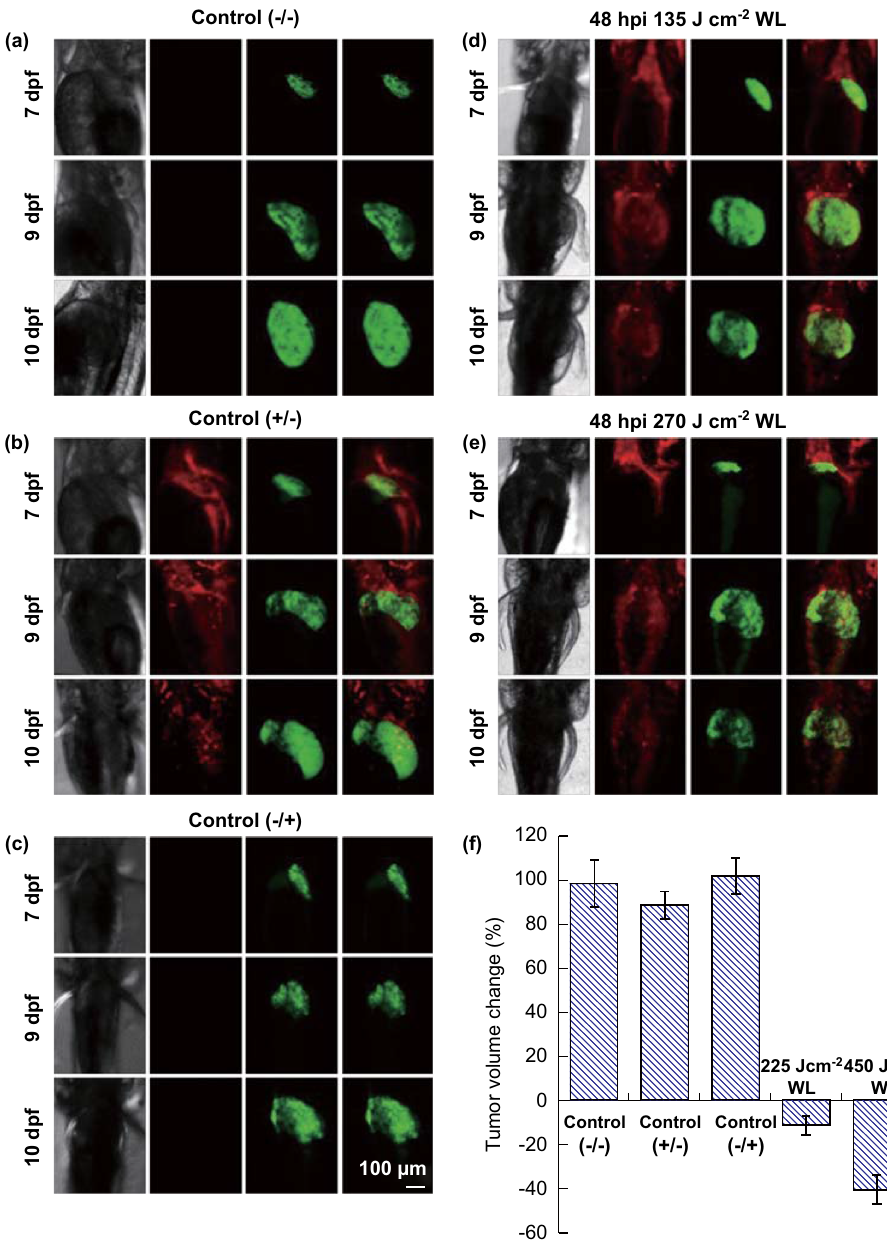
Fig. 4 Change in liver tumor volume for control group: a without injection or illumination ( - / - ), b with injection and without illumination ( - / ? ) and c without injection and with illumination ( ? / - ). Change in liver tumor volume for group injected with NPs on 7 dpf and treated: d with 135 J cm - 2 of illumination 9 dpf and e with 270 J cm - 2 of illumination of 9 dpf. f Graph depicting the percentage of tumor volume change on 10 dpf relative to the volume on 9 dpf before light treatment for all five groups, n = 14; confocal k ex = 488 nm, green fluorescent protein k em = 509 nm, PPDCT k em = 660